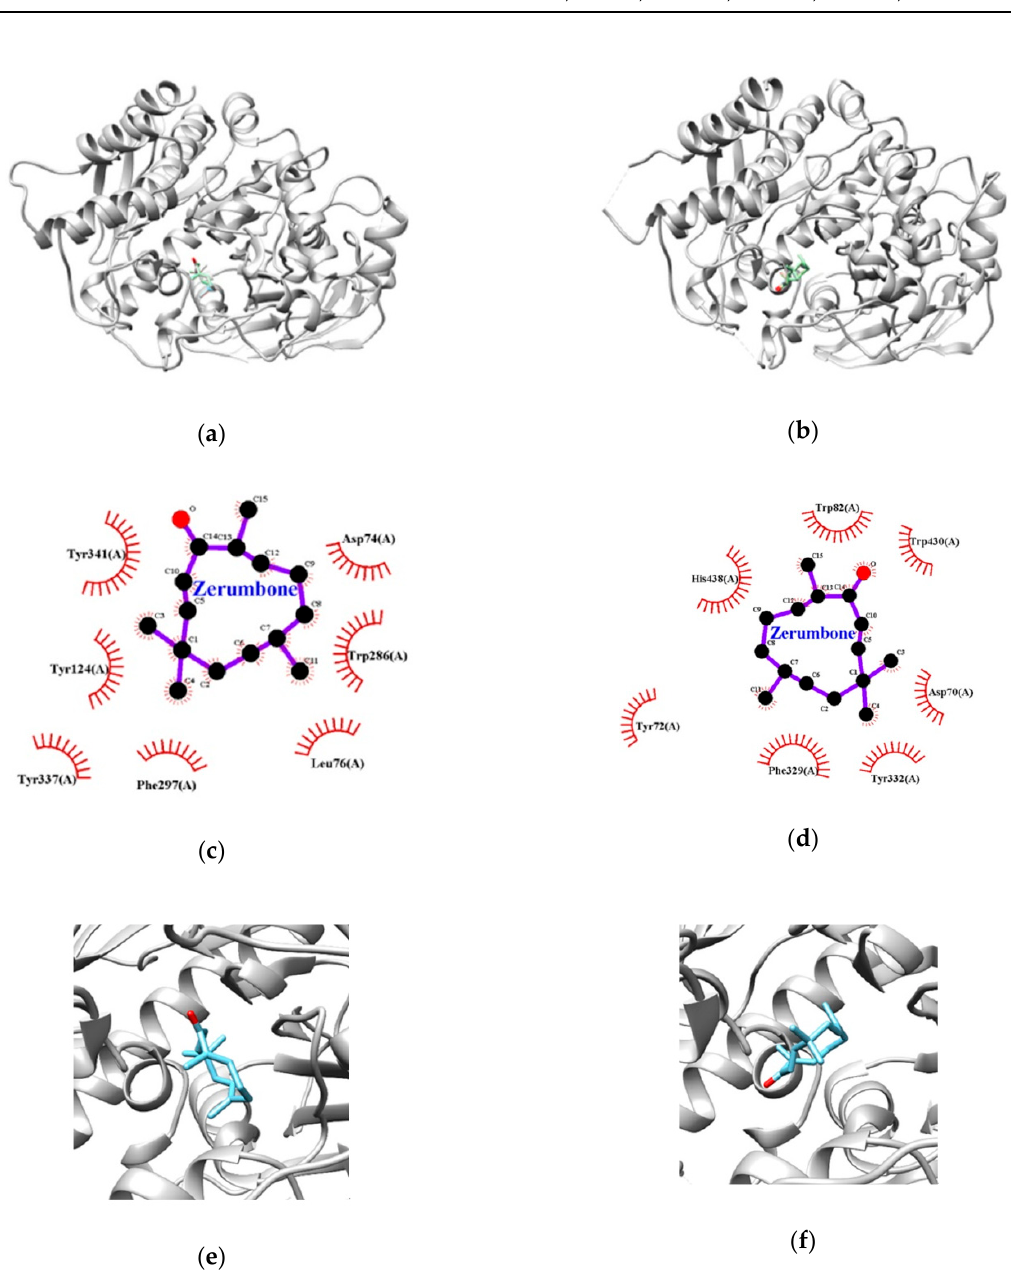
Figure 3. Representations of the best poses of zerumbone in docking with AChE ( a ) and BChE ( b ). Zoomed in view of the zerumbone binding site at AChE ( c ) and BChE ( d ). The hydrophobic interaction between AChE ( e ), BChE ( f ), and zerumbone. The hydrophobic interactions are depicted as red dashed semicircles.